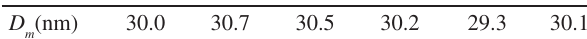
Ag granular alloy. a) Powder; b) 10 90 = 700 °C. ann